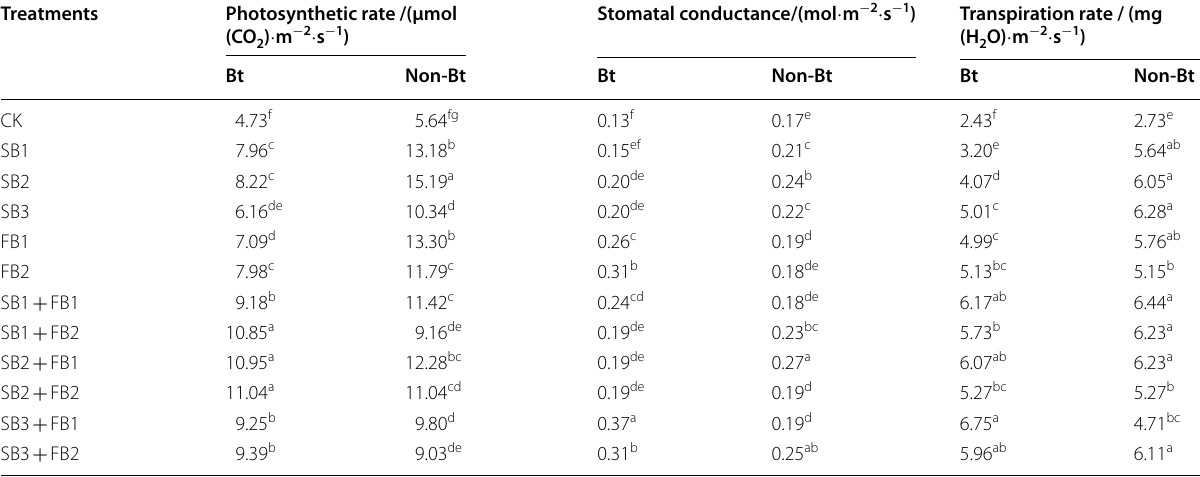
Values are means of three replicates with two plants per replicate (n SB1: 1 mg spray; SB1